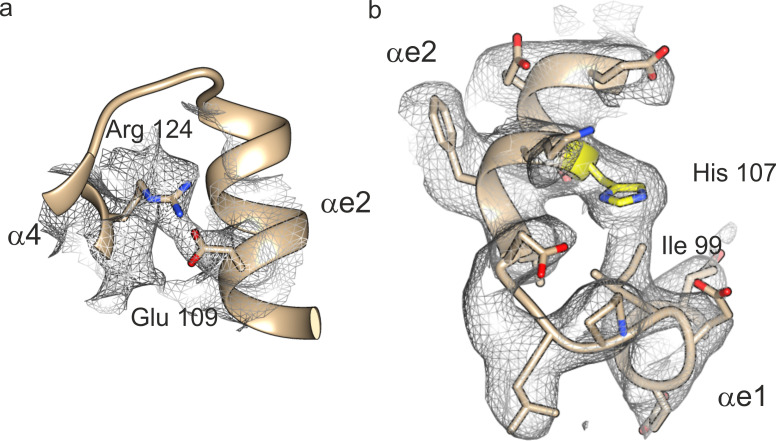
Stabilizing Elements of Extension domain.(a) R124 in α4 of the core spike and E109 in αe2 in the extension domain form a salt bridge, which is visible as continuous density in the EM-map of DHBc (wire representation). The close-up shows chain C. (b) H107 in αe2 forms a hydrophobic interaction with I99 in αe1 and thus stabilizes the fold of the lower part of the extension domain.